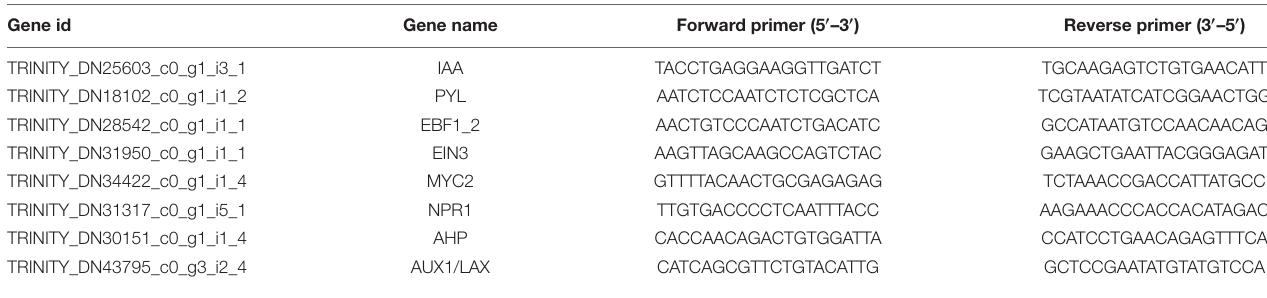
TABLE 1 | Primers used for quantitative real-time PCR (qRT-PCR)